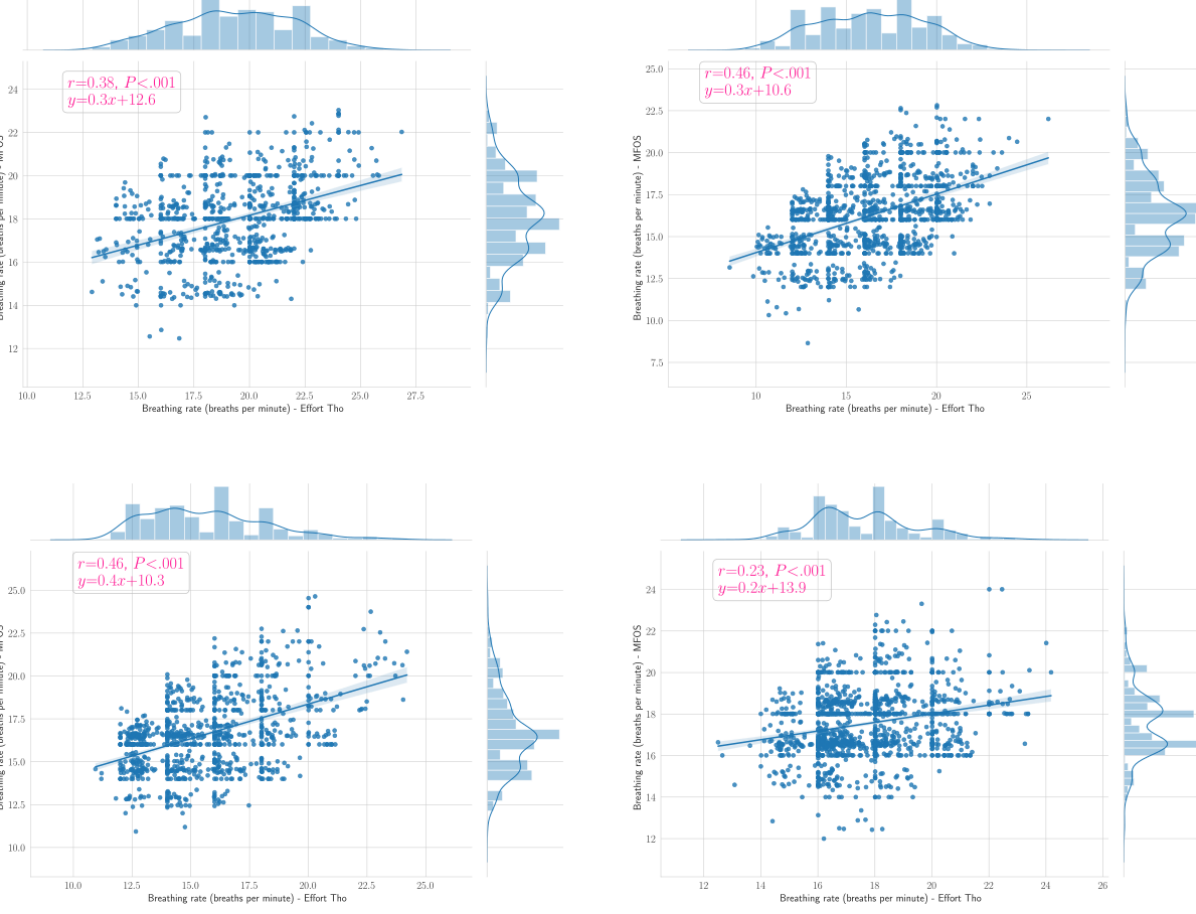
Figure 12. Pearson correlation plots of the respiratory rates for patients 3, 4, 5, and 9 (ie, top left, top right, bottom left, and bottom right, respectively). The blue circles represent reference RR against the estimated respiratory rate, and the blue line represents the fitted line. MFOS: microbend fiber optic